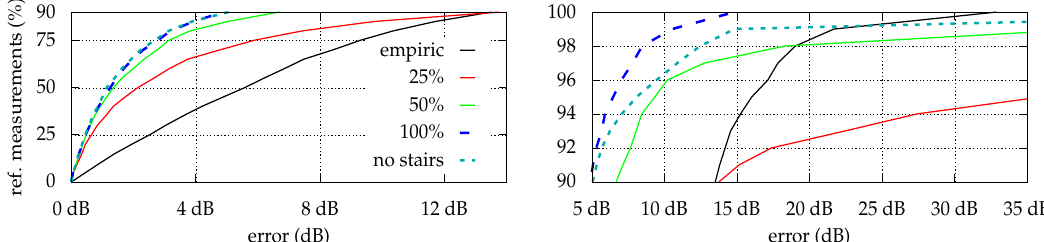
Figure 6. Impact of reducing the number of reference measurements for optimizing model per